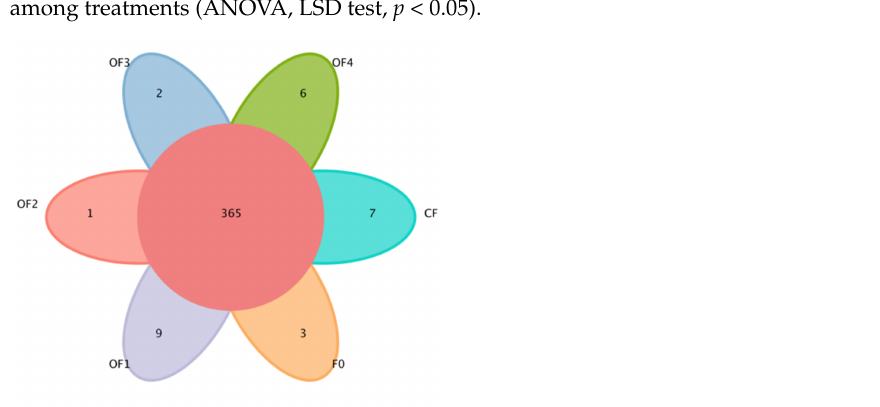
Figure 3. Venn graph showing the number of shared and unique fungal OTUs among fertilization treatments. F0, no fertilizer (F0); CF, conventional NPK fertilizer, OF1, biochar +